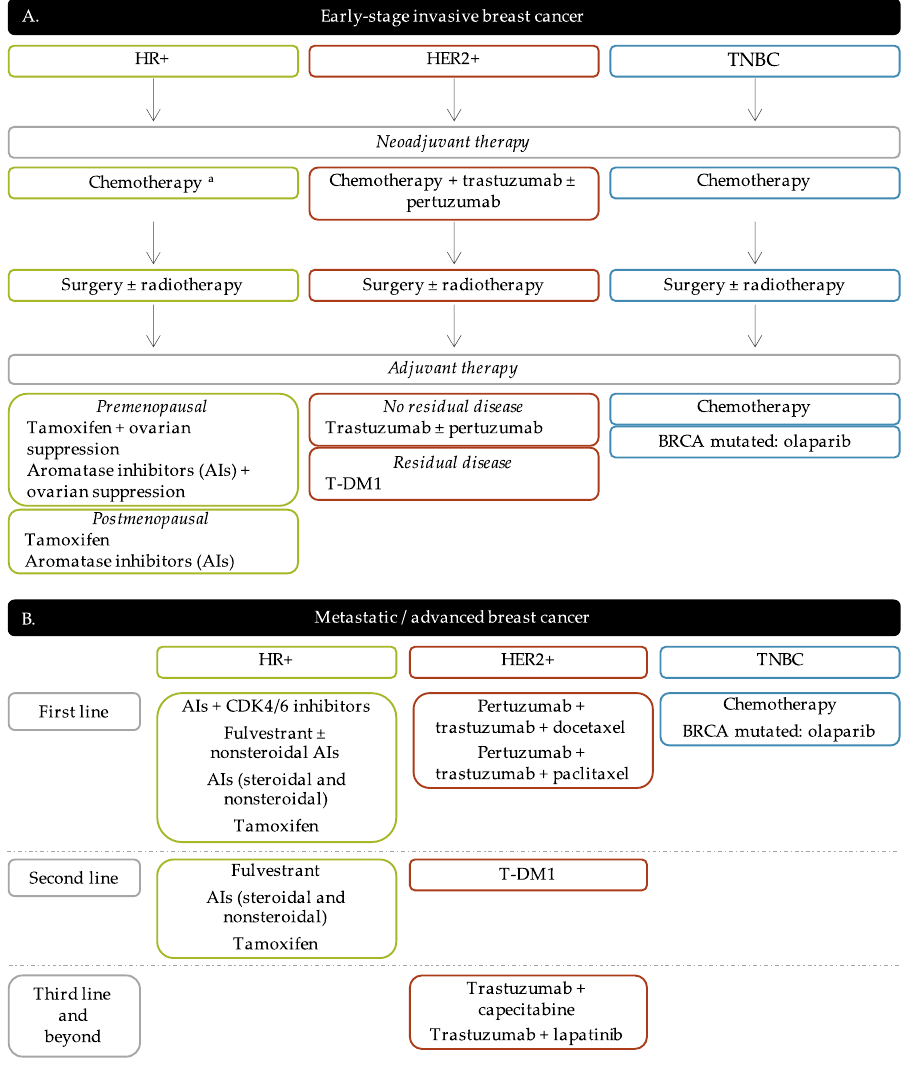
Figure 2. Breast cancer treatment flow diagram. ( A ). Early-stage breast cancer. ( B ). Metastatic/advanced breast cancer. a Neoadjuvant chemotherapy for HR+ BC patients is not systematic. It is mainly administered to luminal B BC patients and/or elder BC patients. HR+: hormone receptors positive; HER2+: human epidermal growth factor receptor 2 positive; TNBC: triple-negative breast cancer; AIs: aromatase inhibitors; T-DM1: trastuzumab-emtansine.